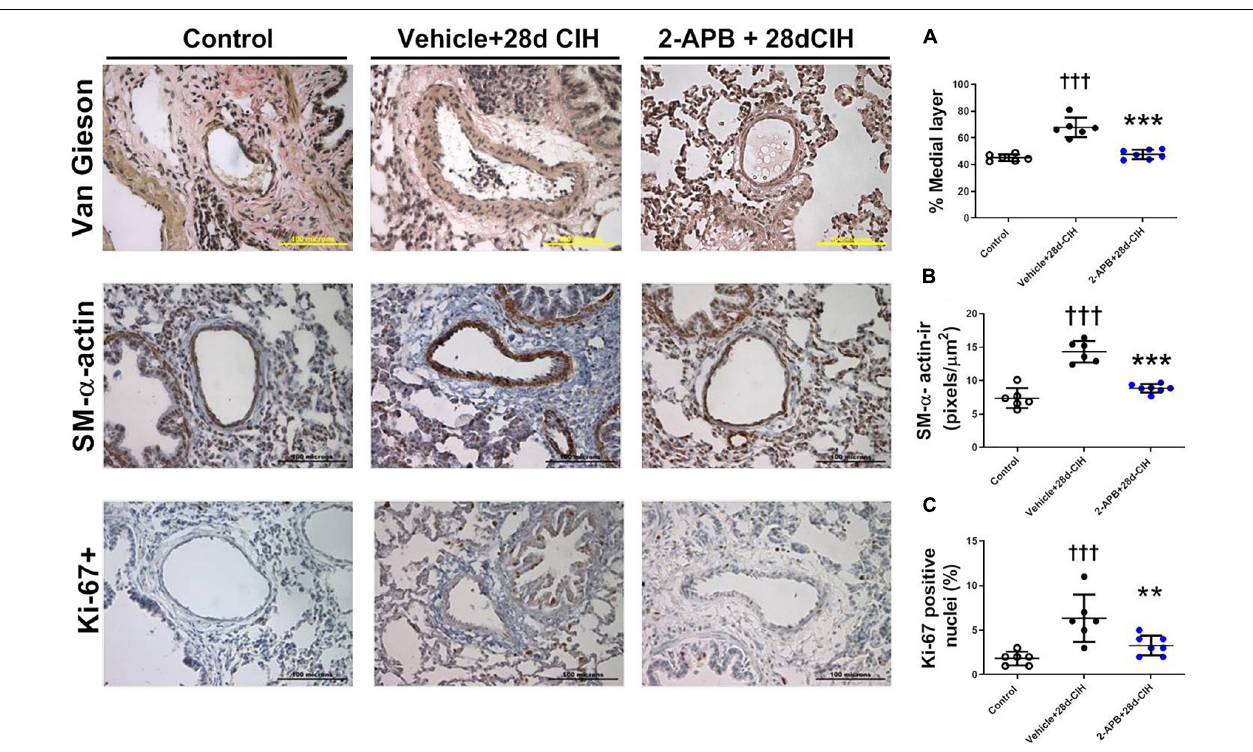
FIGURE 2 | Effect of 2-APB on pulmonary vascular remodeling induced by chronic intermittent hypoxia. (A) Medial layer (ANOVA P < 0.0001). (B) α -actin immunoreactivity in the medial layer (ANOVA P < 0.0001). (C) Ki-67 positive cells in PASMC (ANOVA P = 0.0009) of control (empty circles, n = 6), Vehicle + 28d-CIH (black circles, n = 6), and 2-APB + 28d-CIH rats (blue circles, n = 7). The % of medial layer was measured as (muscle area - lumen area)/(muscle area * 100). Scale bar = 100 µ m. ††† P < 0.001 vs. all groups, ** P < 0.01 vs. Vehicle + 28d-CIH *** P < 0.001 vs. Vehicle + 28d-CIH, One way ANOVA-followed by Newman Keuls